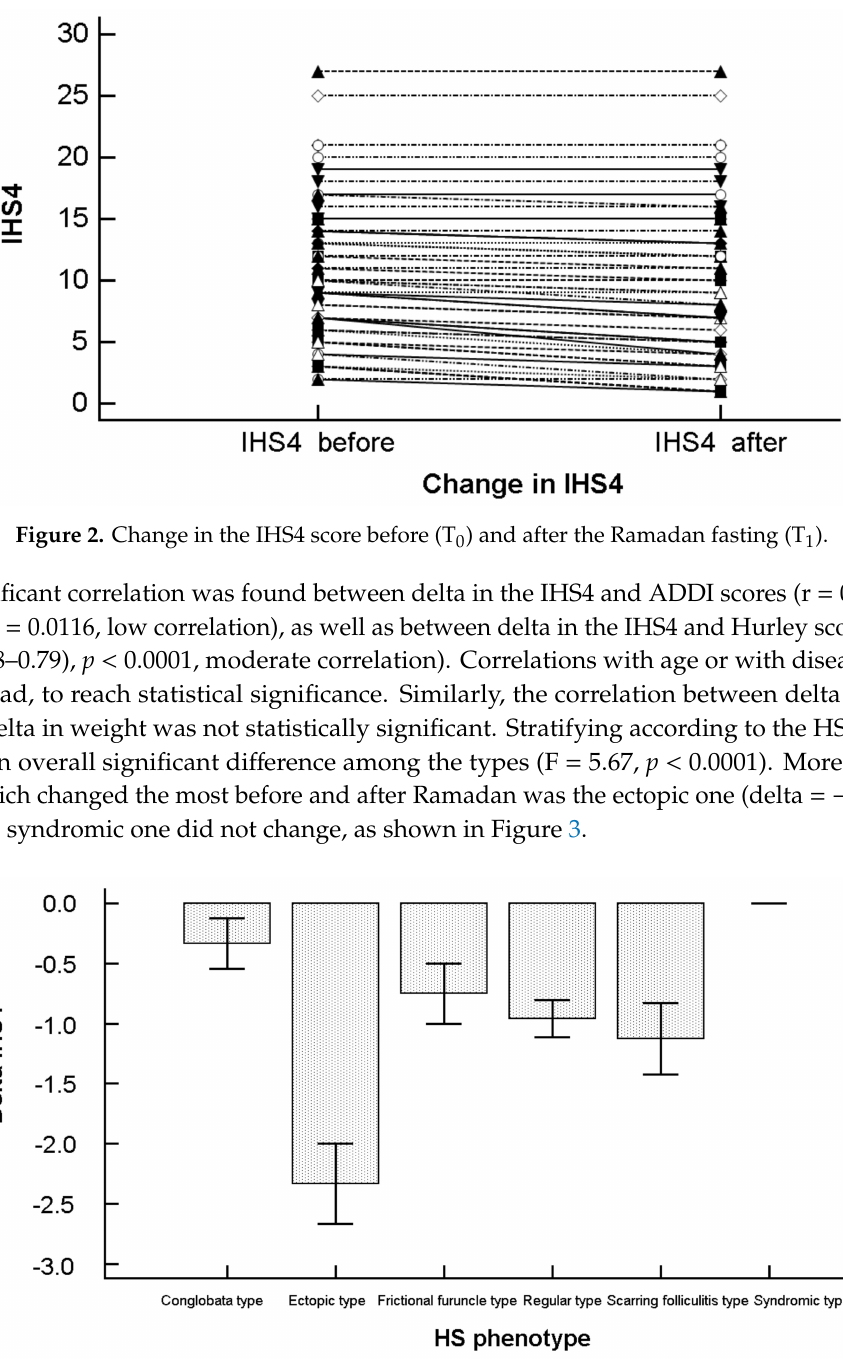
Figure 3. Change in the IHS4 score before (T 0 ) and after (T 1 ) Ramadan broken down according to the HS